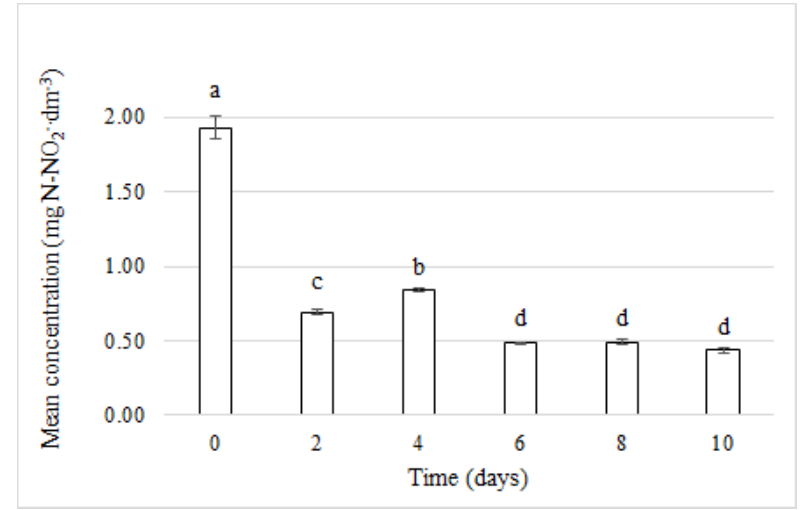
Figure 3. Changes in N-NO 2 − concentration during cultures of Chlorella minutissima in wastewater (mean ± SD; ANOVA F (5, 48) = 2501; p < 0.001; mean over each columns not marked with the same letter is significantly different at p < 0.001).